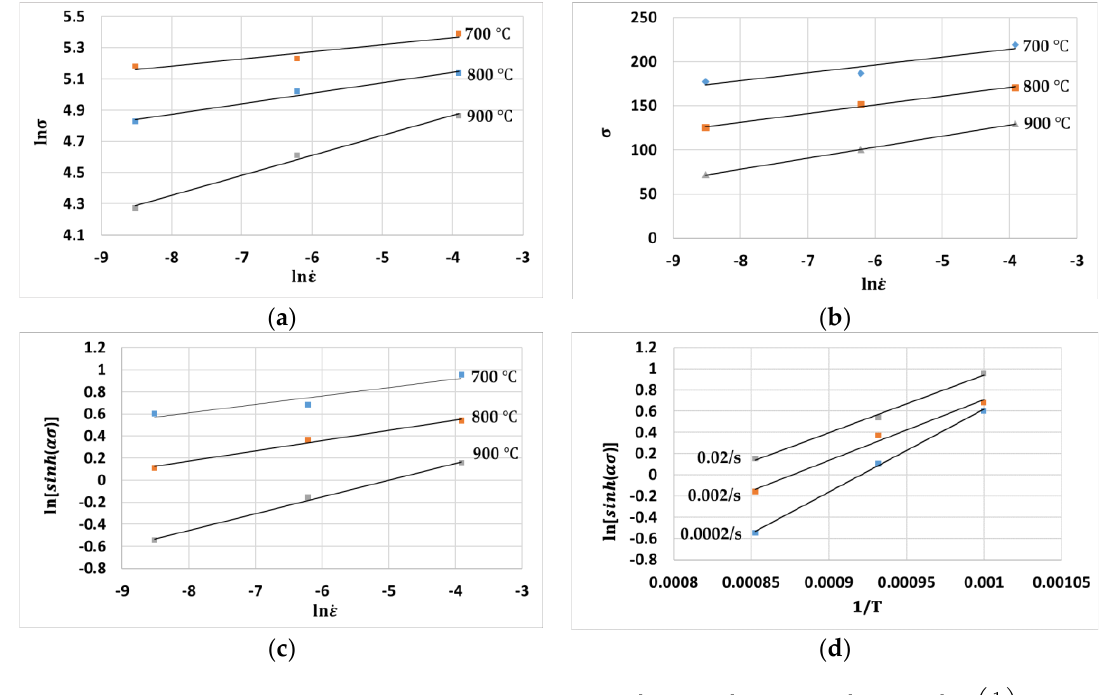
Figure 2. Plots of ( a ) ln σ − ln